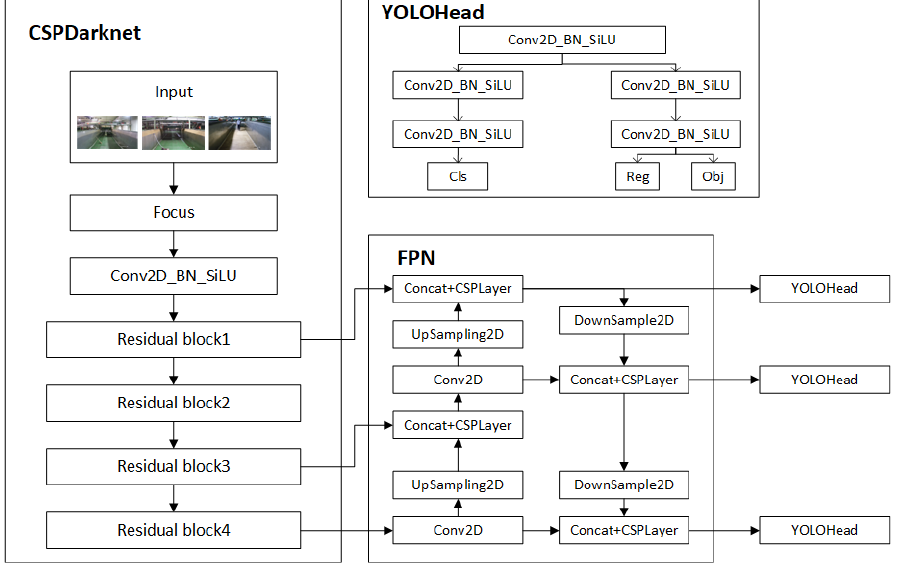
Figure 5. YOLOX network. It consists of three parts: CSPDarkNet, FPN, and YOLO head. CSP- Darknet is the backbone feature extraction network of YoloX; FPN is the enhanced feature extraction network of YoloX; Yolo Head is the classifier and regressor of